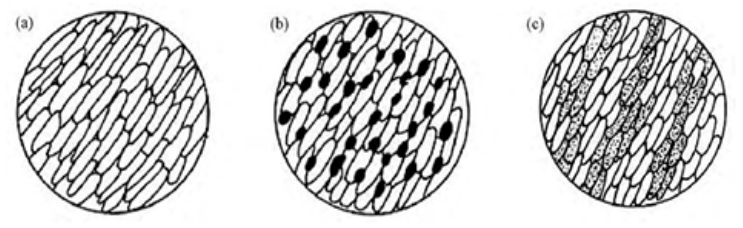
Figure 2. Schematic diagram of sub-temperature quenching refinement mechanism [5]: ( a ) quenching; ( b ) quenching in the two-phase region; ( c ) tempering. Reprinted with permission from Ref. [5]. 2019, Journal of Heat Treatment of Metals .